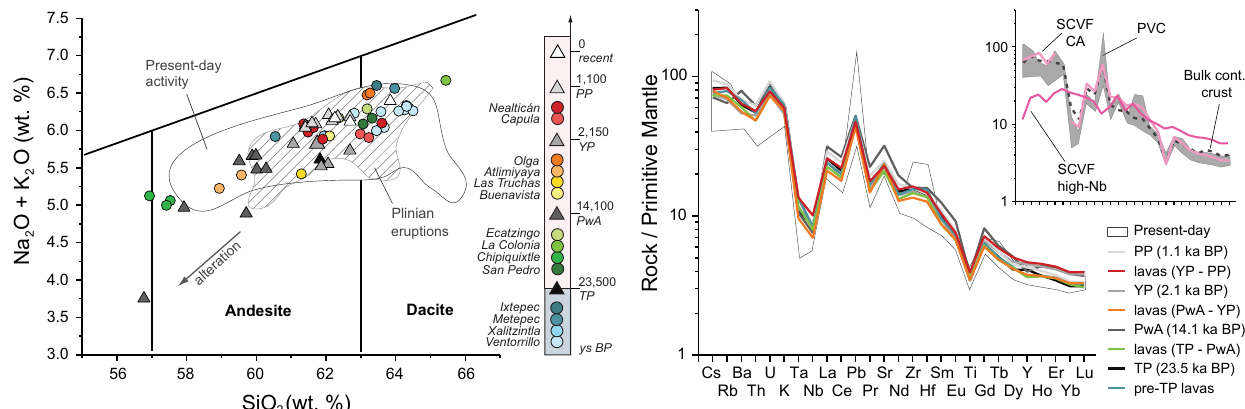
Figure 4: Trace element concentrations normalised to primitive mantle [Sun and McDonough 1989] for major Plinian eruptions and the respective interplinian aver- ages, based on all e ff usive samples. Present-day activ- ity data from Schaaf et al. [2005]; Torres-Alvarado et al. [2011]. Inset shows PVC range compared to bulk con- tinental crust [Rudnick and Gao 2003] and representa- tive data for high-Nb and calc-alkaline (CA) lavas from the neighbouring Sierra Chichinautzin Volcanic Field (SCVF) [Straub et al. 2015].